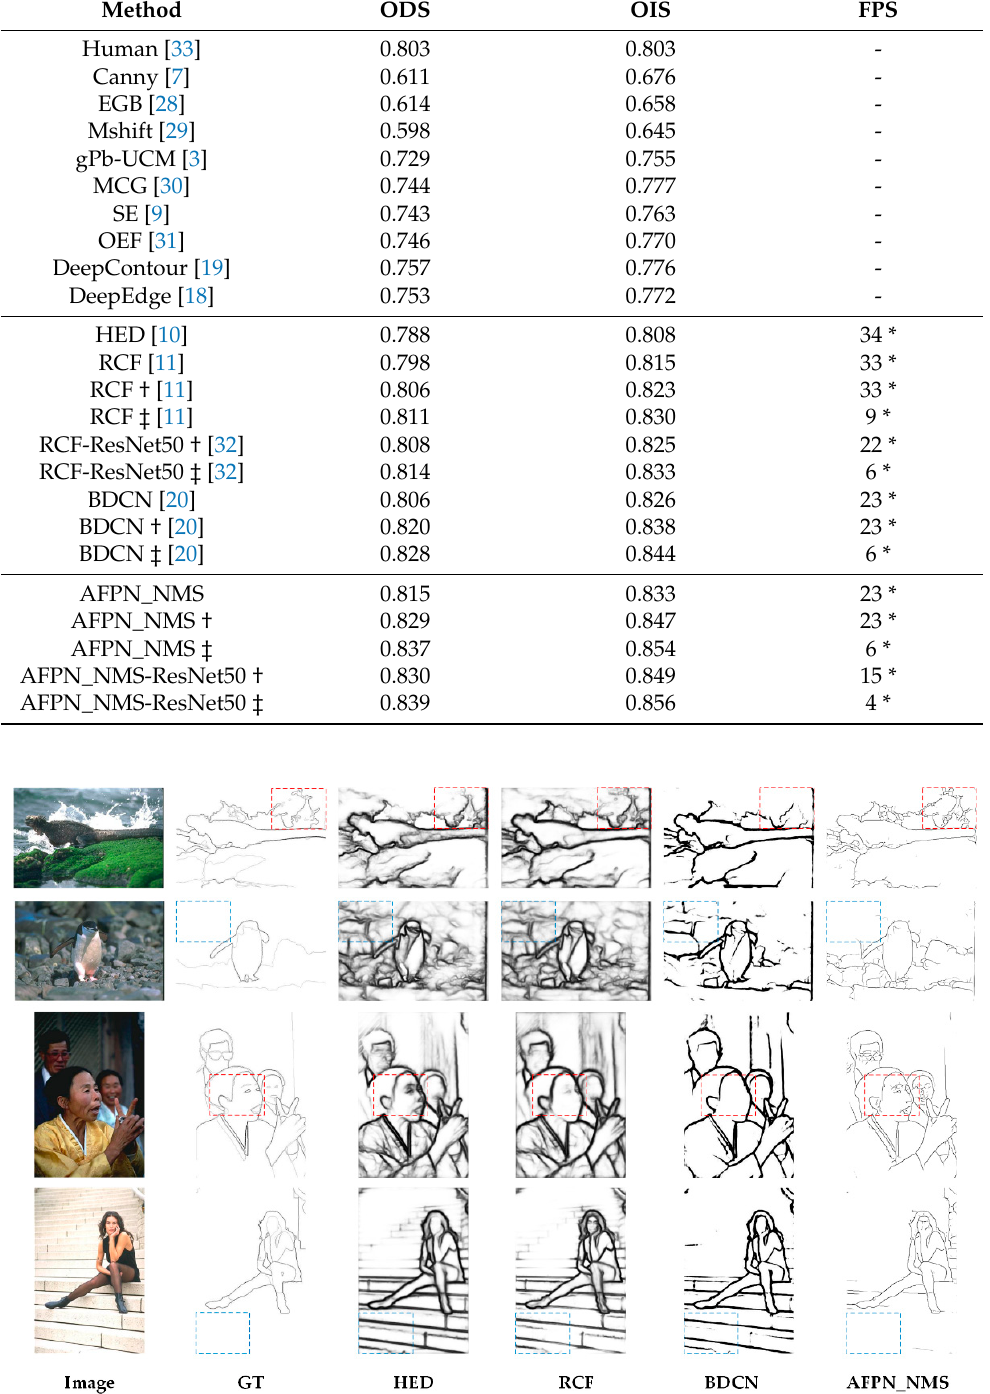
Figure 5. Comparison of edge detection results on the BSDS500 test dataset. Note that all the pre ‐ dictions are end ‐ to ‐ end outputs and not post ‐ processed.